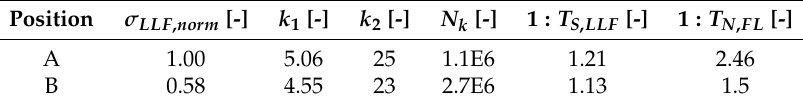
Figure 6. S–N curve for position B. Table 2. Statistically evaluated fatigue